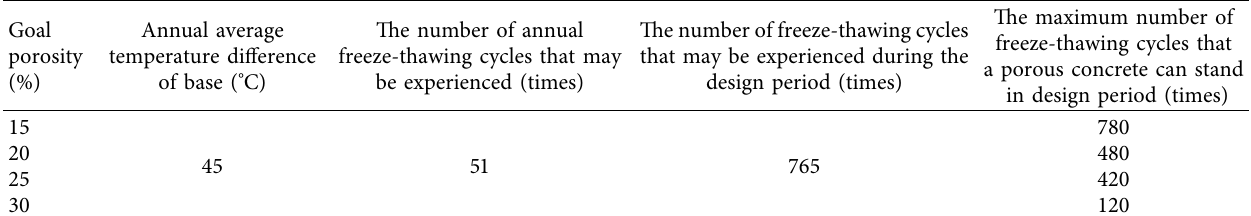
Table 11: The possible frost-thawing cycle times of porous concrete in working environment. Goal